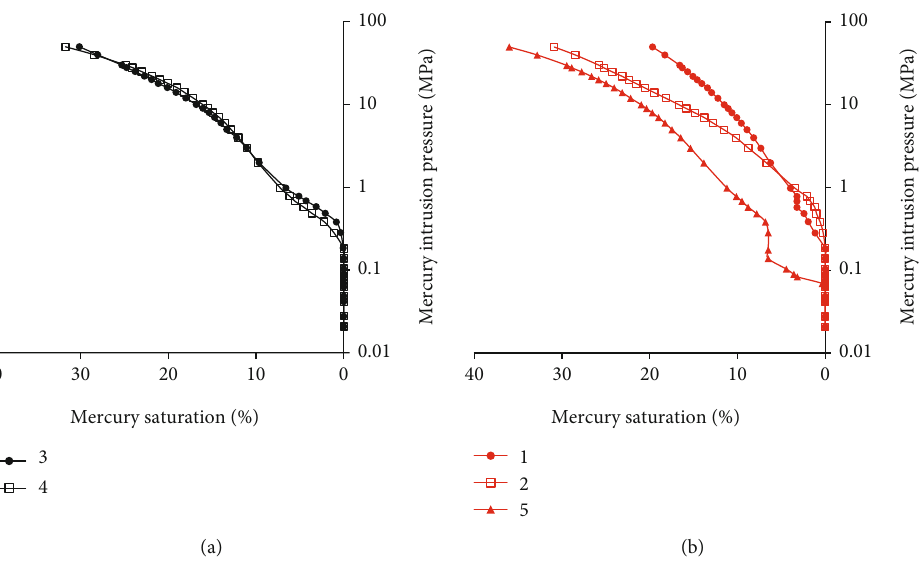
Figure 4: Capillary pressure curve characteristics of (a) BMHS and (b)